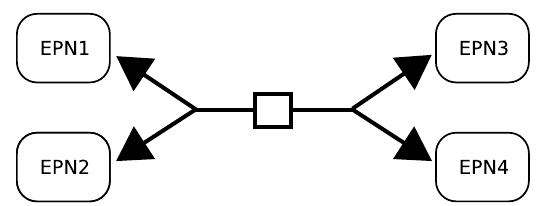
Figure 3.4: A valid reversible process. A process is reversible if its LHS and RHS contain only production arcs.